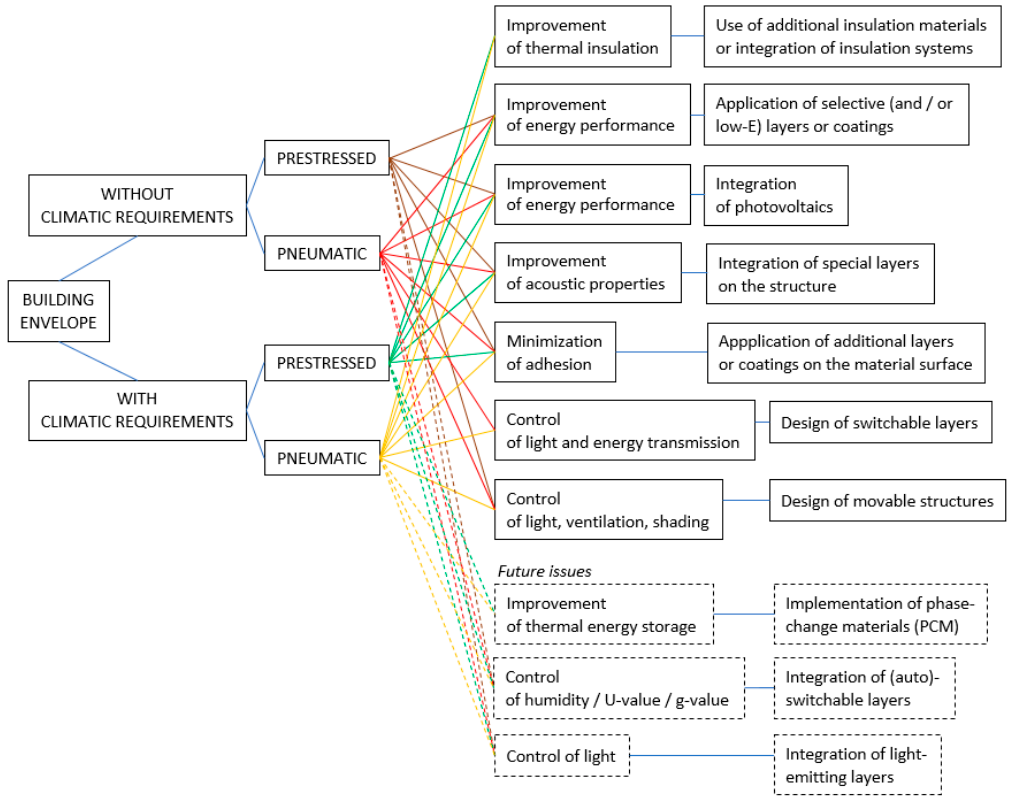
Figure 6. The use of textiles in building facades for enhanced thermal, energy and lightening performances (adapted from [53]).